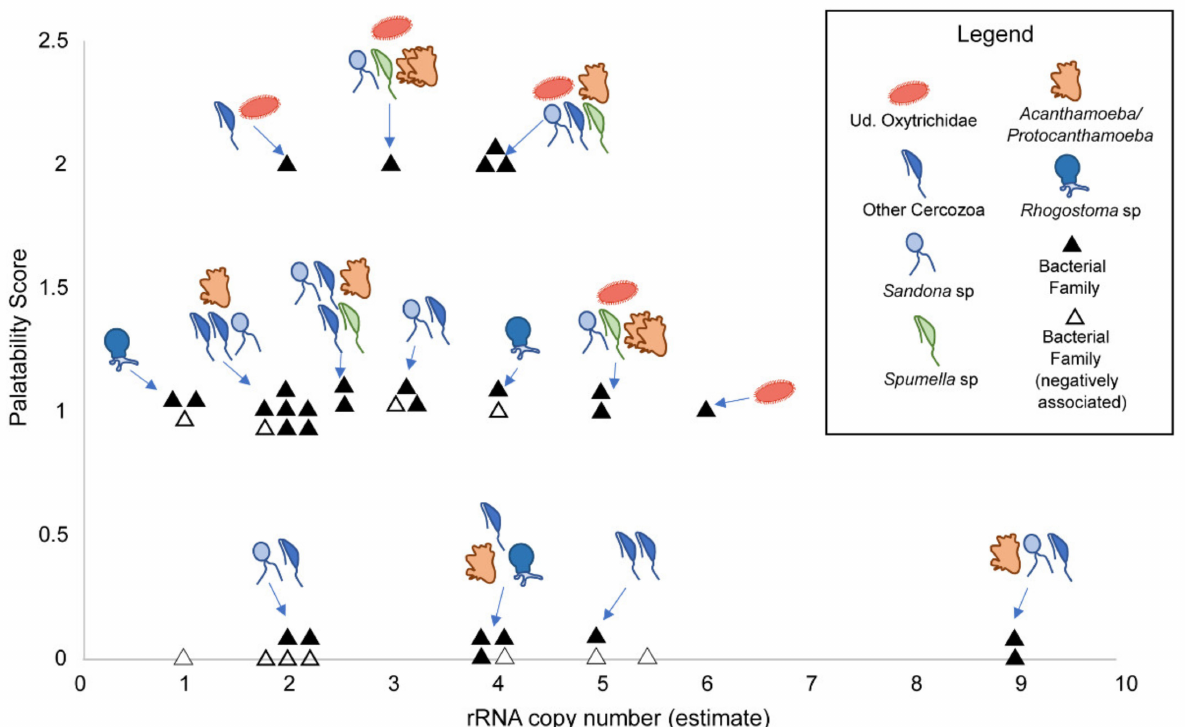
Figure 4. MDV Phagotrophic protists exhibit preferential grazing. A palatability score was assigned to each bacterial family by giving one point for each of the following characteristics: (1) Gram-negative, (2) phototroph, and (3) diazotroph. Associated protists from the network analyses were added and arrows indicate which bacterial cluster the protists are associated with. Roughly half (34 of 74) of the bacterial families were excluded from the analysis because rRNA copy number could not be estimated at the family level. Black-filled triangles denote bacterial families positively associated with a protist in the network analyses, white-filled triangles represented bacterial families negatively associated with a protist in the network analysis. Arrows point to clusters, not individual triangles; each protist can be assumed to be associated with at least one of the bacterial families in a cluster, but how many or which is not specified in this